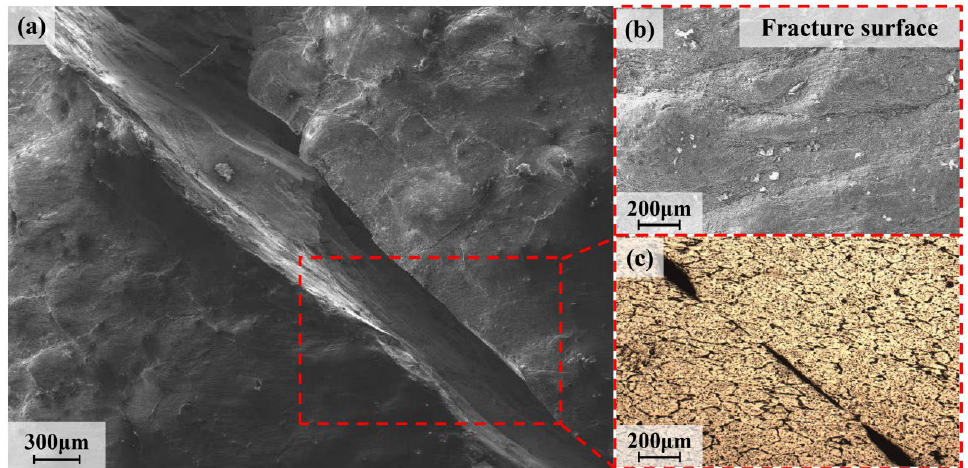
Figure 11. The microstructure of an Mg − 2Sn − 1Ca alloy in 423 K/1 s − 1 thermal compression. ( a ) The crack of the specimen; ( b ) Fracture surface; ( c ) local magnification of crack.